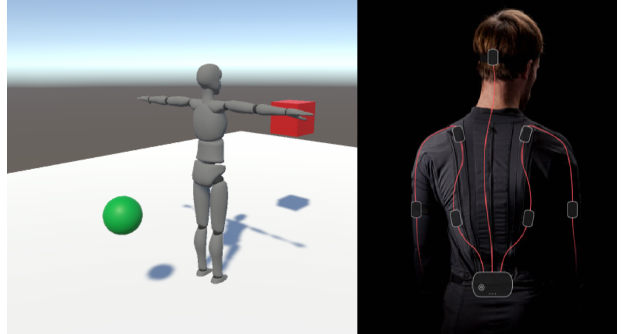
Figure 6. Users had to perform two basic and two advanced tasks using a motion capture suit. Basic tasks included interaction with the two objects, a green sphere and a red box.